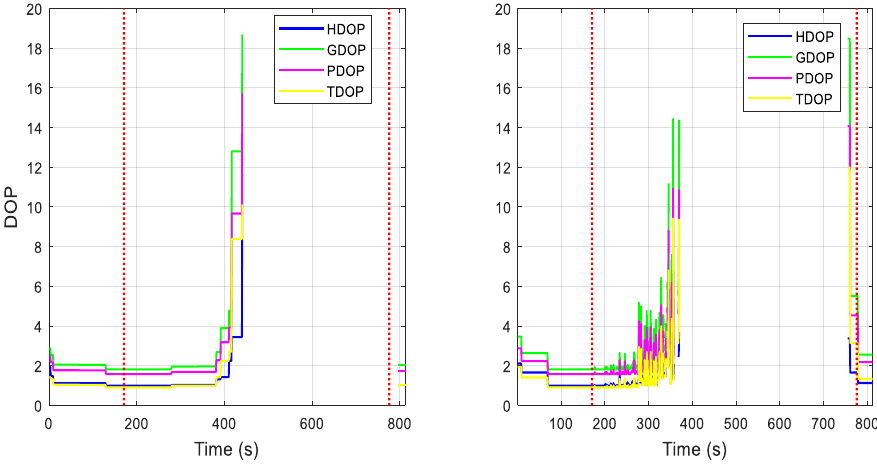
Figure 7. Dilution of precision ( DOP) values of GPS constellation scenarios. ( Left figure )— narrowband interference, ( right figure )—wideband interference.